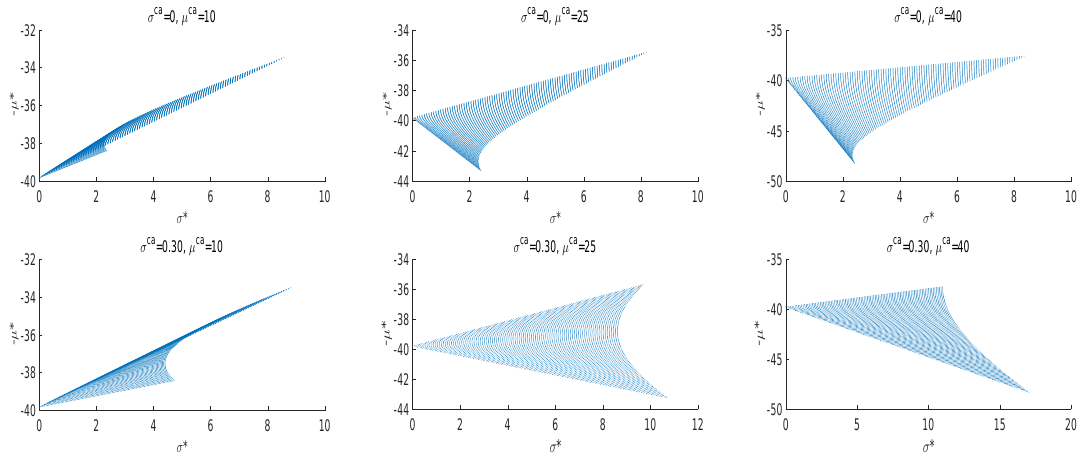
Figure 4. Optimal systemic sets in the EEC mean-standard deviation plane ( − µ ∗ , σ ∗ ) under the two carbon volatility scenarios σ ca = 0 (top) and σ ca = 30% (bottom) for µ ca = 10, 25, 40 (from left to